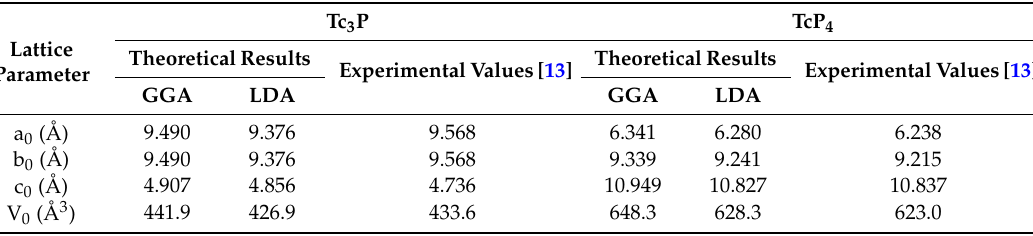
Table 1. Calculated and experimental lattice parameters of the crystal Tc 3 P and TcP 4 at zero